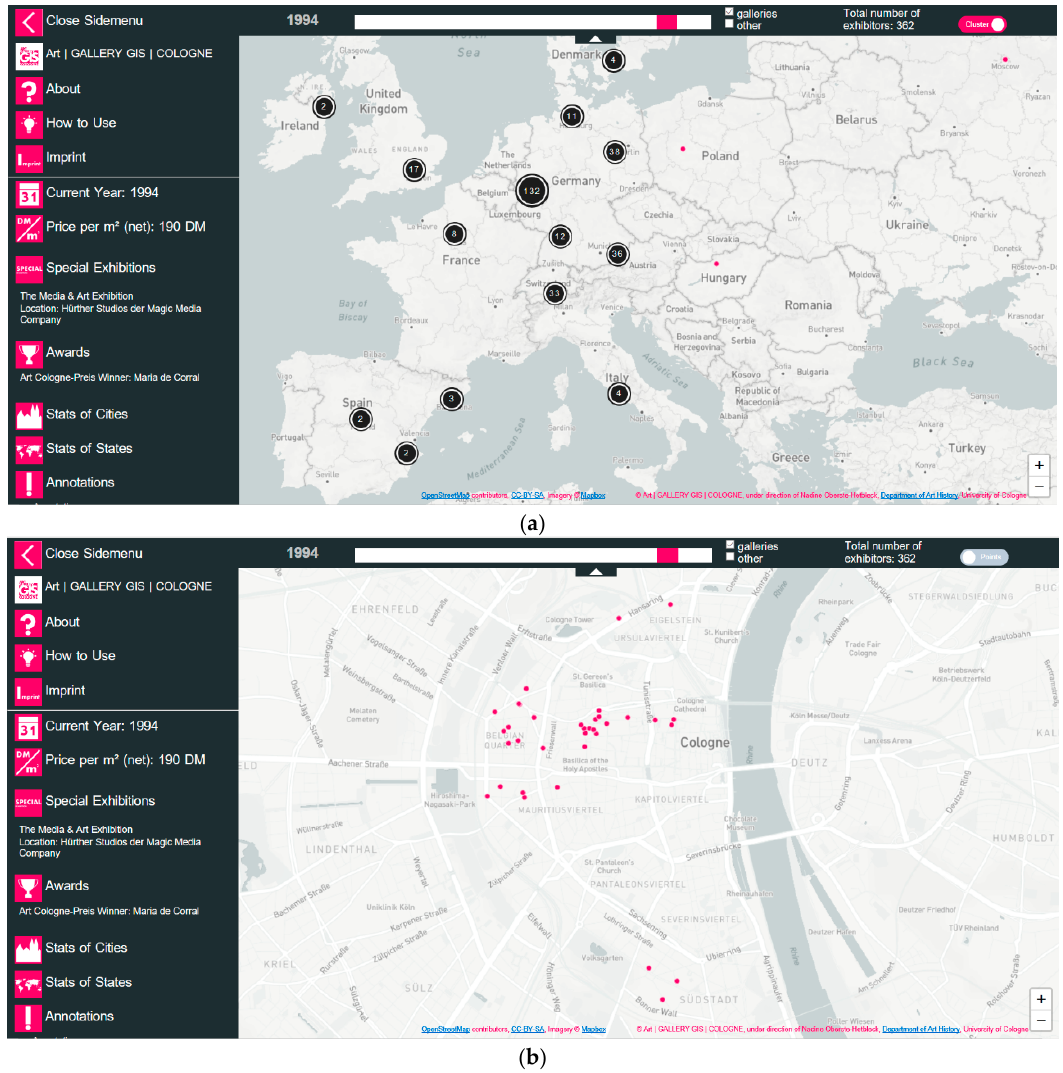
Figure 1. ART|GALLERY GIS|COLOGNE, 1994 ( a ) display mode: cluster, ( b ) display mode: Figure 1. ART | GALLERY GIS | COLOGNE, 1994 ( a ) display mode: cluster, ( b ) display mode: individual individual locations. Used by permission . © ART|GALLERY GIS|COLOGNE. locations. Used by permission. © ART | GALLERY GIS |